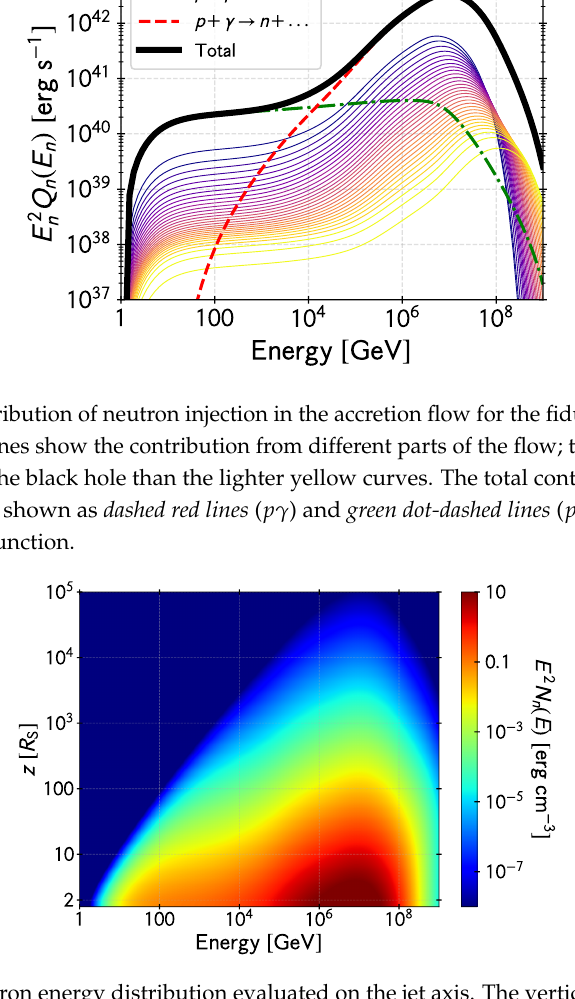
Figure 6. Steady neutron energy distribution evaluated on the jet axis. The vertical axis is the distance to the hole in units of Schwarzschild radii and the horizontal axis is the neutron energy. The color map represents the neutron energy density per unit logarithmic bin of